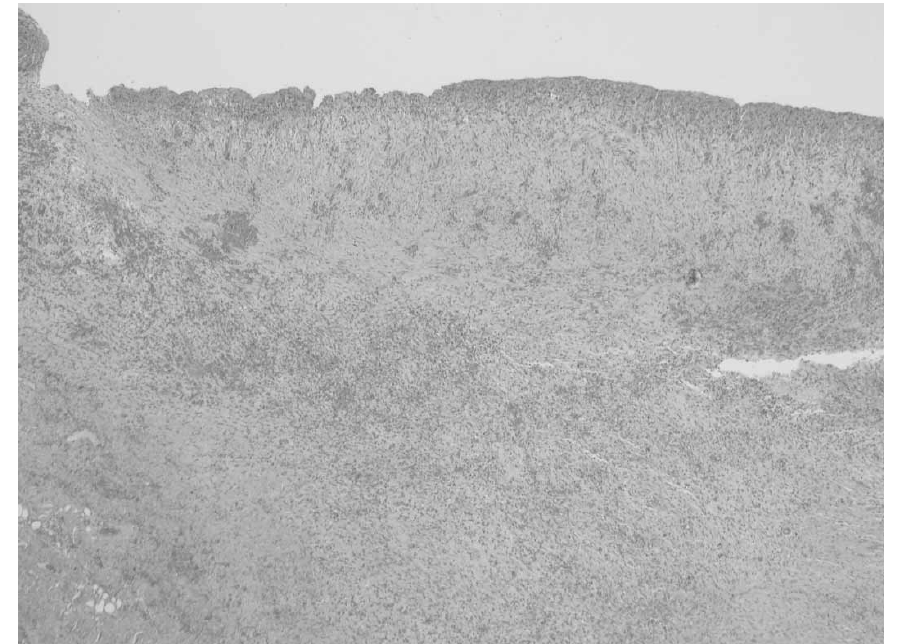
Fig. 3. Proliferation of mesothelial cells associated with fibrinous exudates and fibrosis are seen on the surface of the retroperitoneal biopsy, features of sclerosing